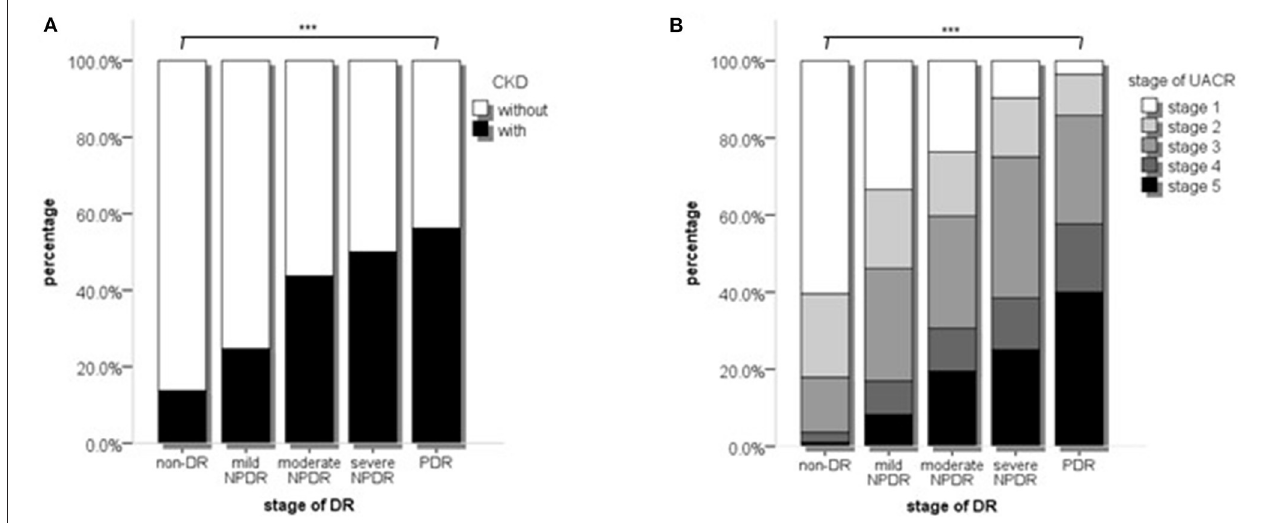
FIGURE 2 | The proportions of different stages of CKD or UACR in different stages of DR. (A) The proportions of different stages of CKD in different stages of DR; (B) The proportion of different stages of UACR in different stages of DR stages. p values were acquired from Chi-square test. CKD, Chronic kidney disease; UACR, Urinary protein; DR, Diabetic retinopathy. *** p < 0.001.